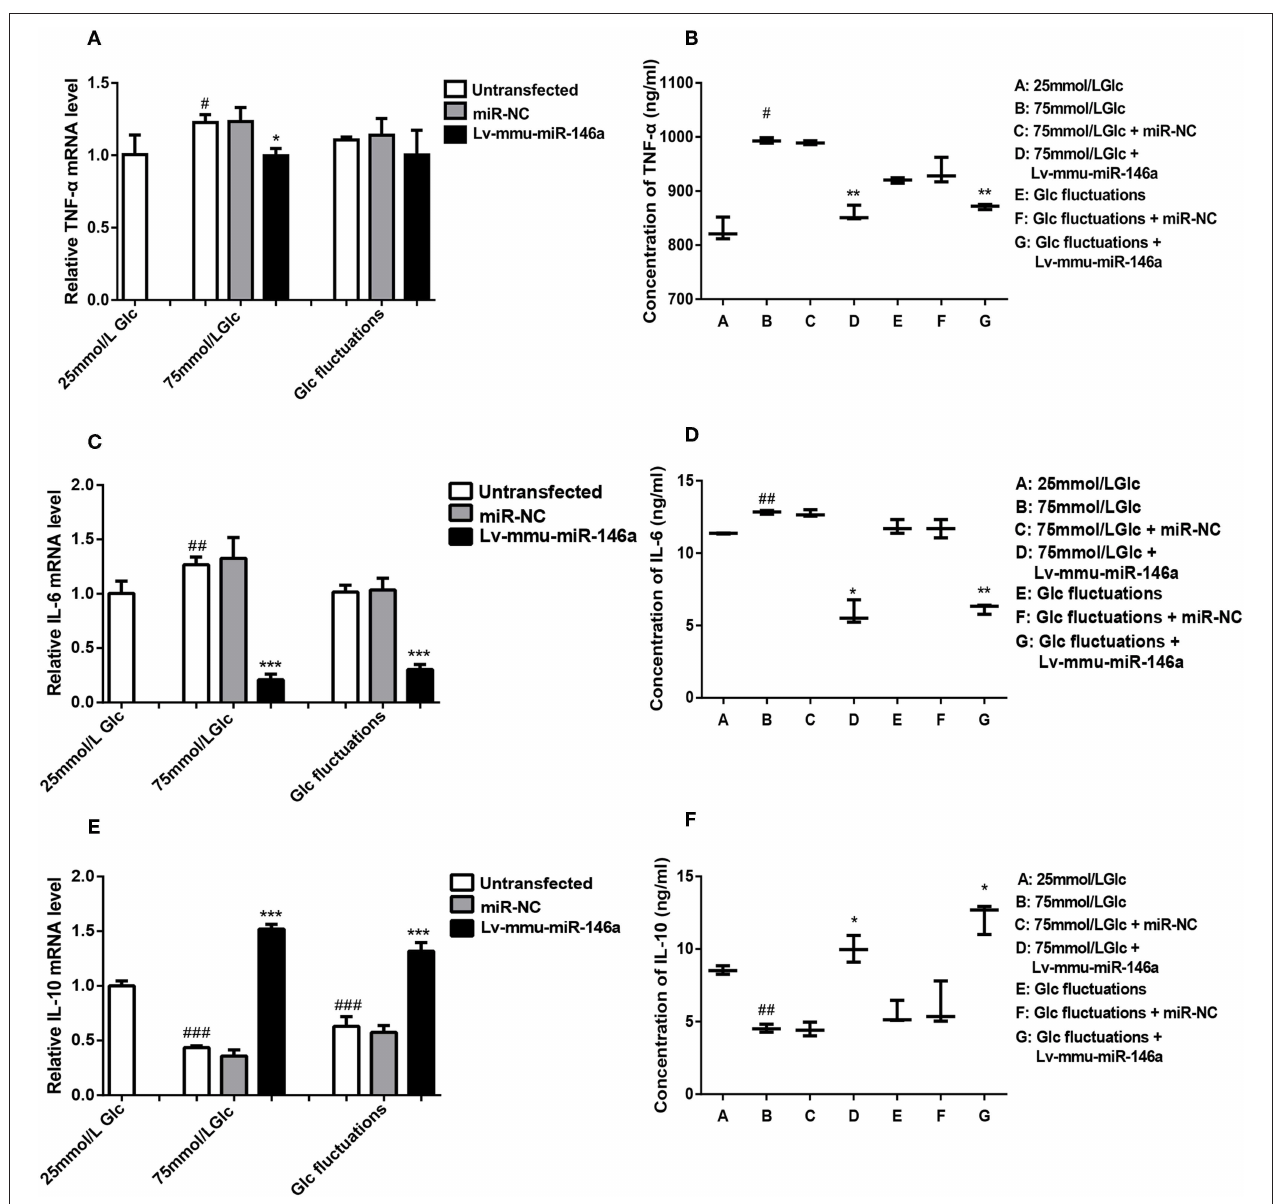
FIGURE 5 | Effects of miR-146a on inflammatory cytokines expression in BV-2 cells induced by high glucose and glucose fluctuation. (A) TNF- α mRNA expression levels. # p < 0.05, 75 mmol/L Glc vs. control; * p < 0.05, 75 mmol/L Glc + Lv-mmu-miR-146a group vs. 75 mmol/L Glc group. (B) ELISA results of TNF- α . # p < 0.05, 75 mmol/L Glc vs. control; ** p < 0.01, 75 mmol/L Glc + Lv-mmu-miR-146a group vs. 75 mmol/L Glc group; Glc fluctuation + Lv-mmu-miR-146a group vs. Glc fluctuation group. (C) IL-6 mRNA expression levels. ## p < 0.01, 75 mmol/L Glc vs. control; *** p < 0.001, 75 mmol/L Glc + Lv-mmu-miR-146a group vs. 75 mmol/L Glc group; *** p < 0.001, Glc fluctuation + Lv-mmu-miR-146a group vs. Glc fluctuation group. (D) ELISA results of IL-6. ## p < 0.01, 75 mmol/L Glc vs. control; * p < 0.05, 75 mmol/L Glc + Lv-mmu-miR-146a group vs. 75 mmol/L Glc group; ** p < 0.01, Glc fluctuation + Lv-mmu-miR-146a group vs. Glc fluctuation group. (E) IL-10 mRNA expression levels. ### p < 0.001, 75 mmol/L Glc vs. control; ### p < 0.001, Glc fluctuation vs. control; *** p < 0.001, 75 mmol/L Glc + Lv-mmu-miR-146a group vs. 75 mmol/L Glc group. *** p < 0.001, Glc fluctuation + Lv-mmu-miR-146a group vs. Glc fluctuation group. (F) ELISA results of IL-10. ## p < 0.01, 75 mmol/L Glc vs. control; * p < 0.05, 75 mmol/L Glc + Lv-mmu-miR-146a group vs. 75 mmol/L Glc group; * p < 0.05, Glc fluctuation + Lv-mmu-miR-146a group vs. Glc fluctuation group.